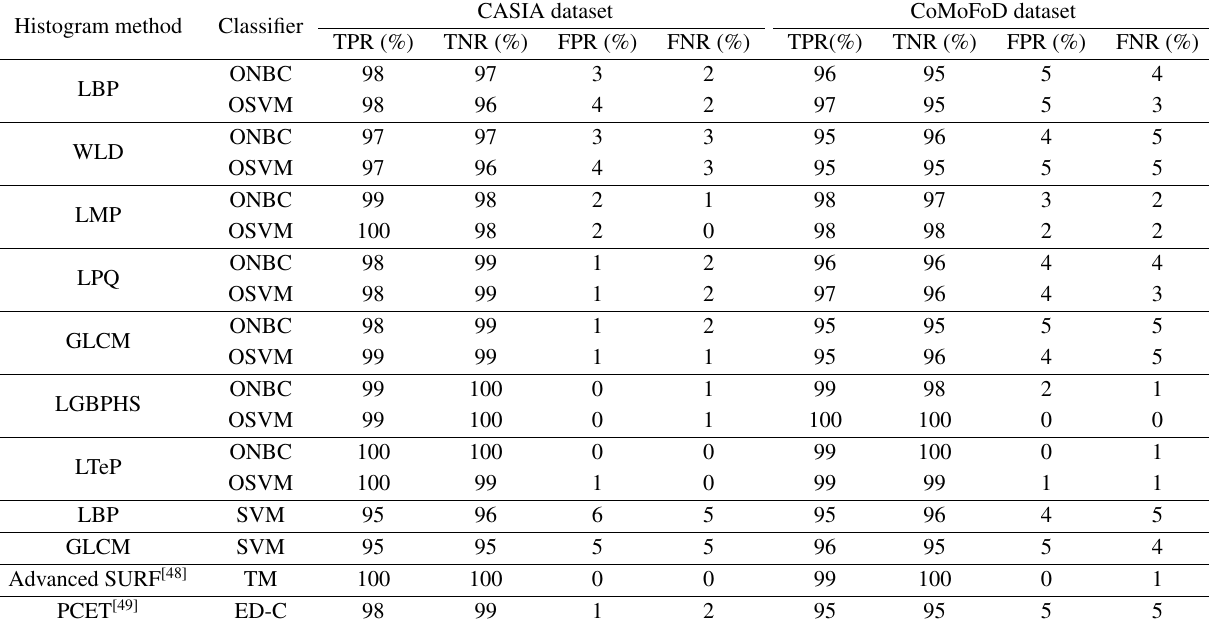
Table 1 Performance of CMFD algorithms on plain CMF